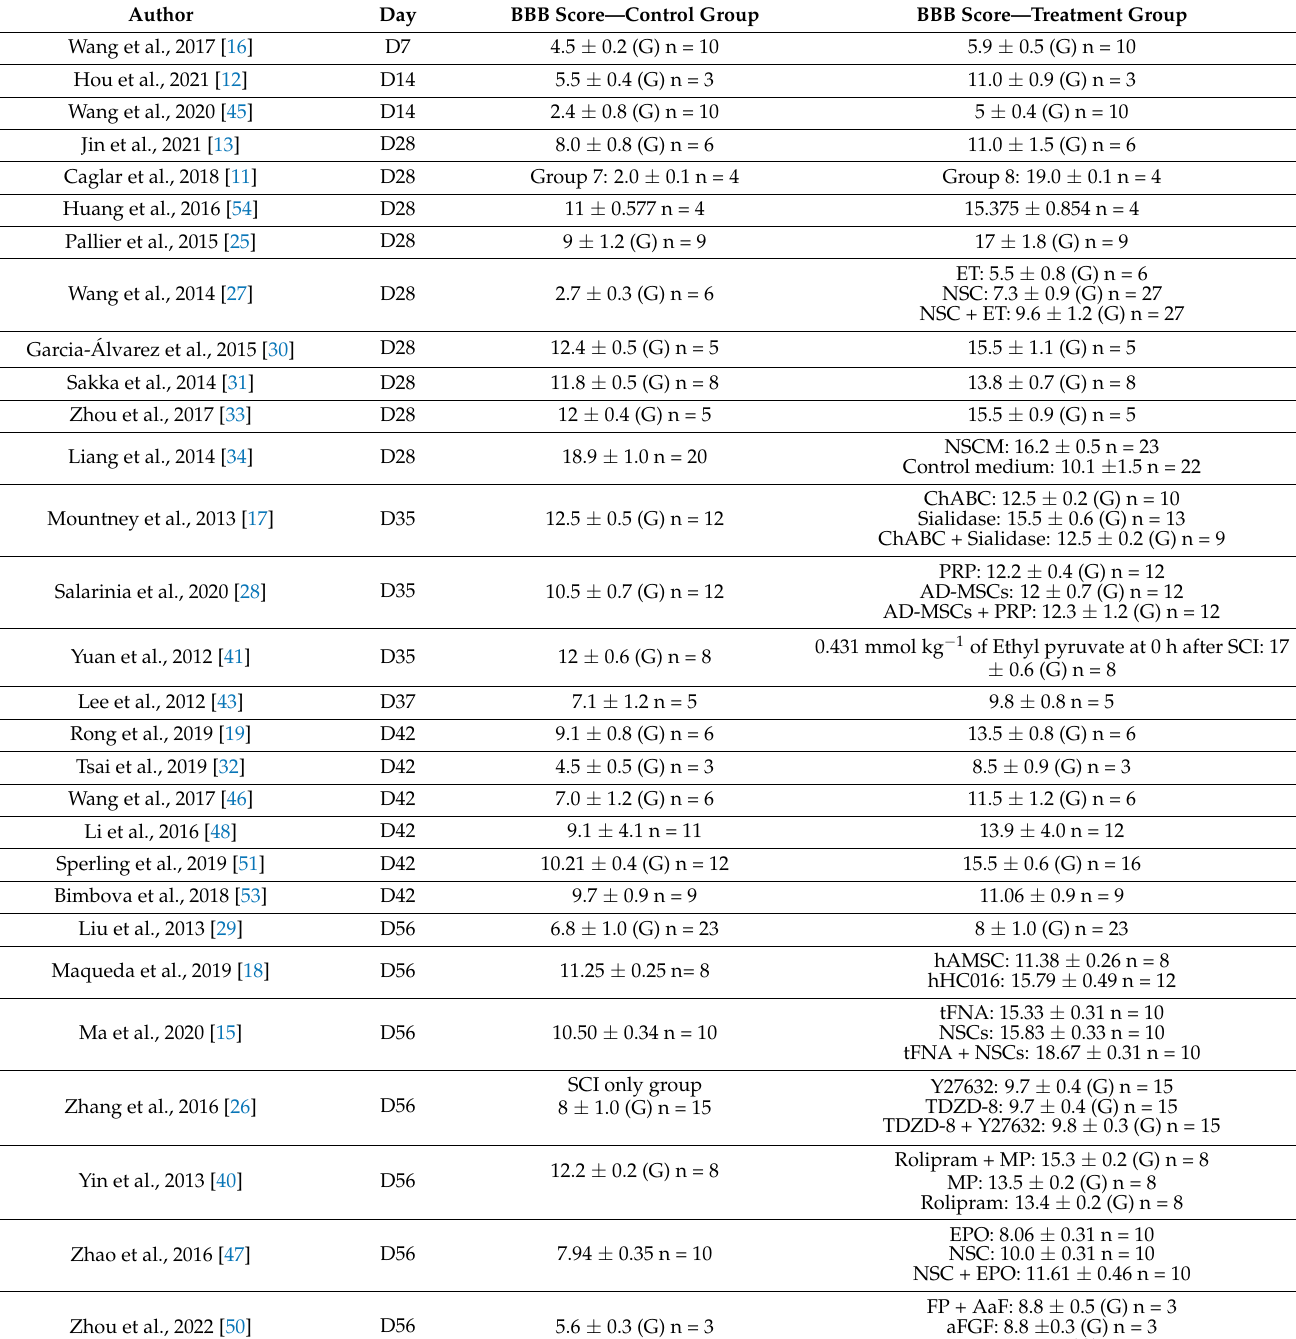
Table 2. Summary of the BBB scores for control and treatment groups from the studies that performed the BBB